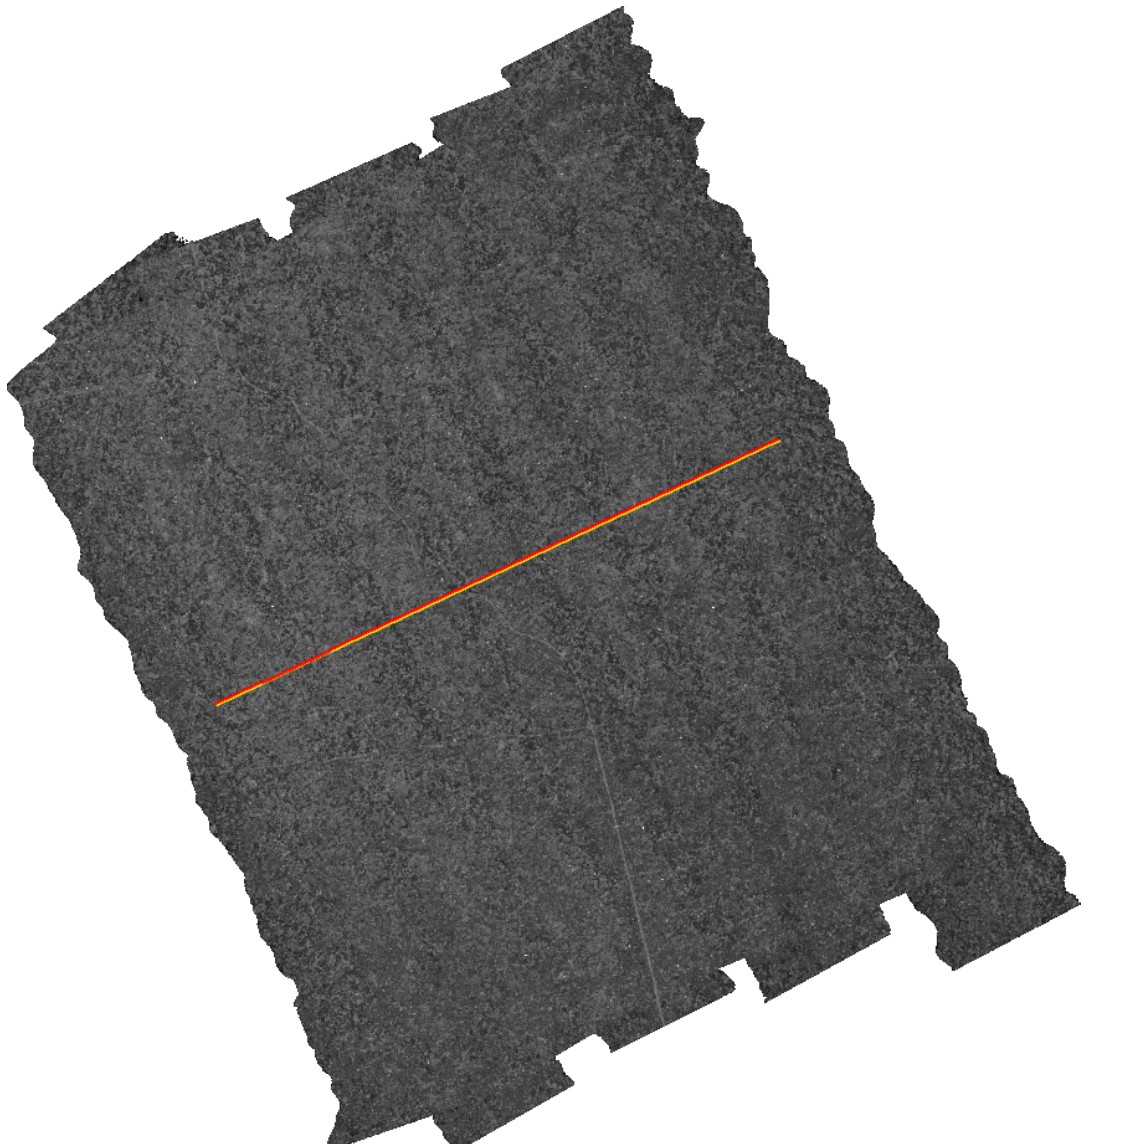
Figure 20. Trajectory in yellow on intensity, circular bin, experiment. Corresponding estimated positions are drawn in